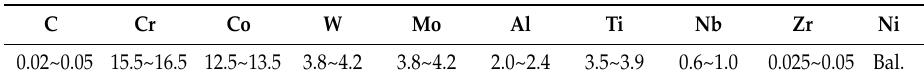
Table 1. Components of FGH96.